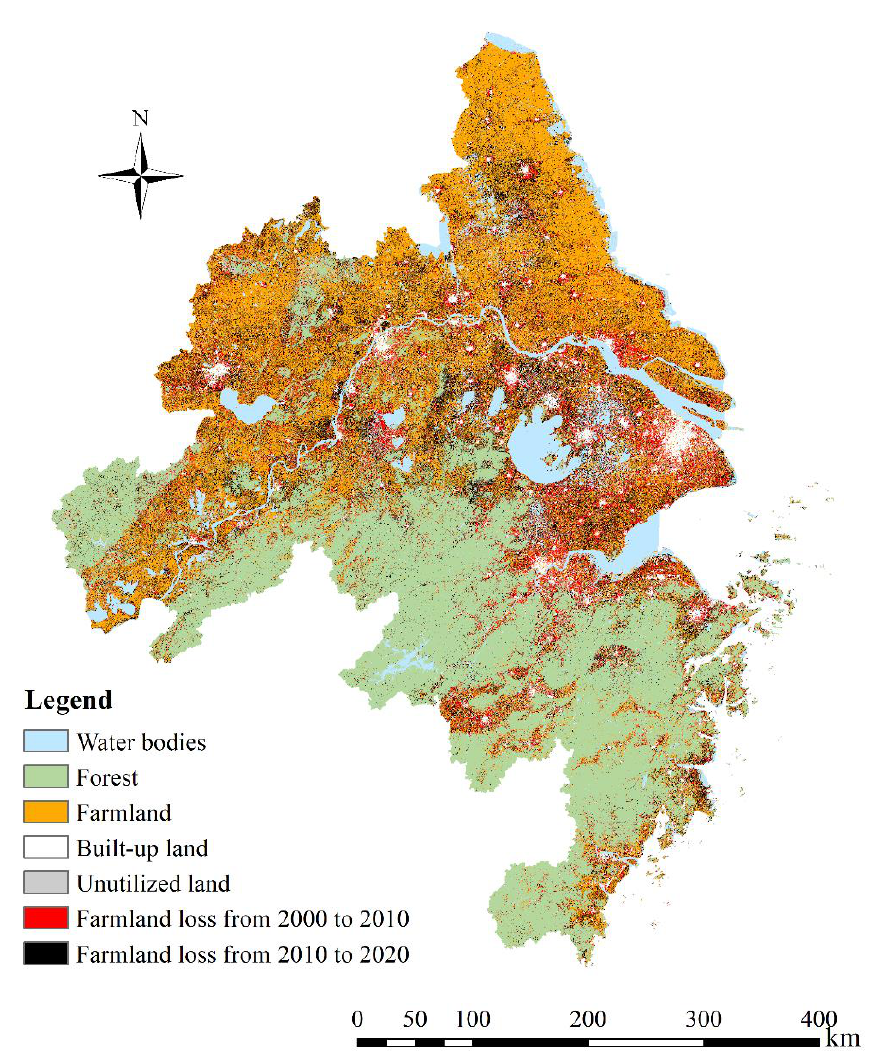
Figure 4. Farmland loss during different time periods from 2000 to 2020.